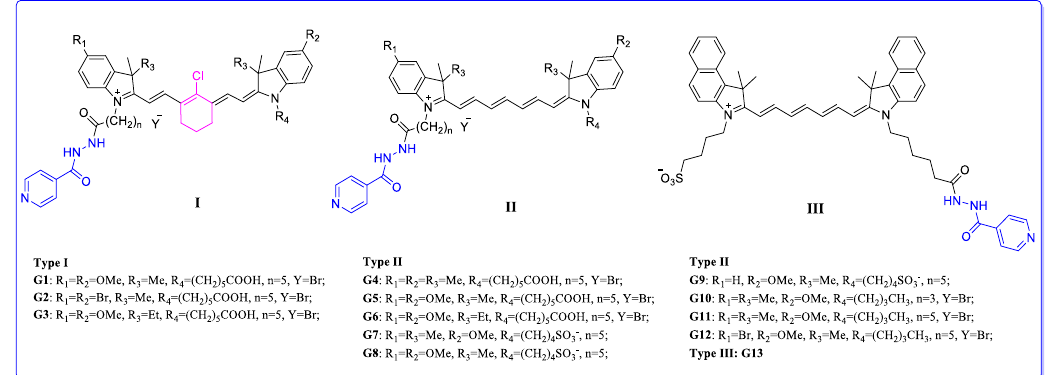
Figure 1. Structures of the designed compounds.